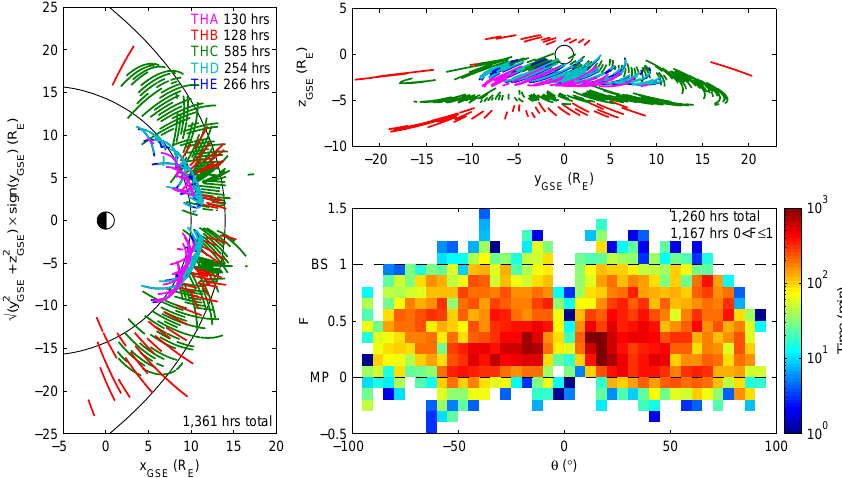
Fig. 1. Top right and left: all THEMIS magnetosheath crossings greater than an hour in duration during June–September 2008 projected radially (left) and in the GSE y–z plane (top right). The average magnetopause and bow shock locations determined by the Shue et al. (1998) and Farris et al. (1991) models, respectively, are shown as the black lines. Bottom right: coverage in the magnetosheath model, binned by aberrated solar zenith angle θ and fractional magnetosheath distance F , where the colour scale represents the amount of time in minutes spent by spacecraft in each bin. The magnetopause and bow shock are indicated by the dashed black